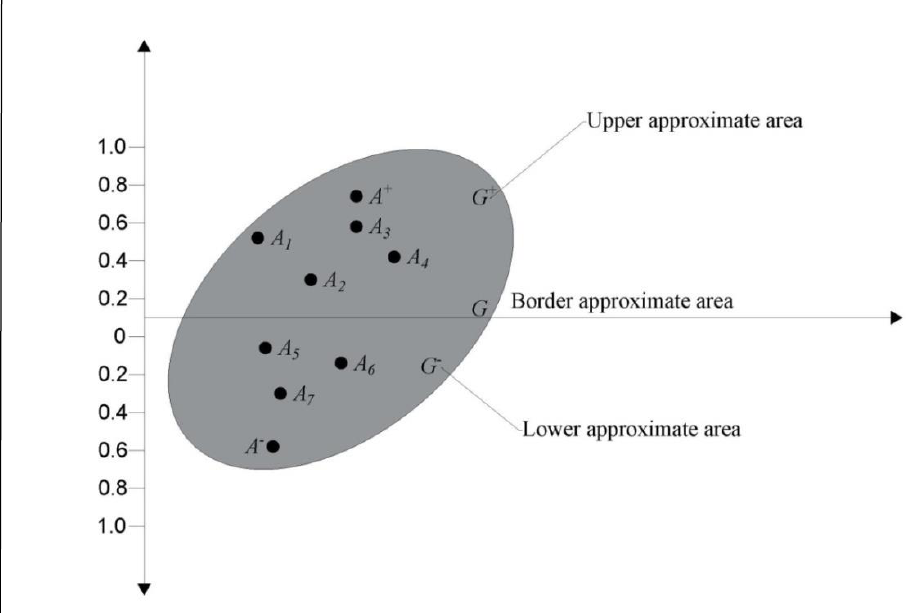
Figure 8 – Representation of the upper (𝐺 + ) , lower (𝐺 − ) and border (𝐺) approximate